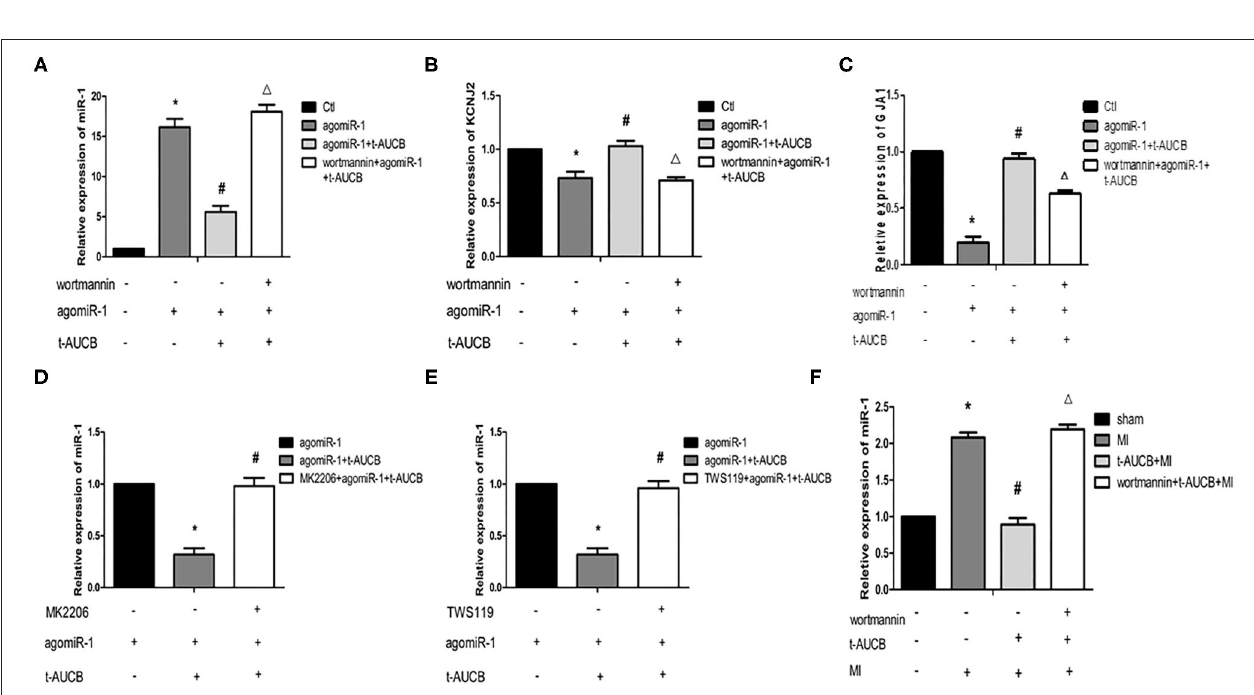
FIGURE 1 | expressions of SRF ( n = 4). (D) Protein bands of SRF silencing mouse model ( n = 4). (E) Relative mRNA expressions of SRF silencing mouse model ( n = 4). (F) SRF participated in t-AUCB-mediated regulation of MI areas in MI mice ( n = 3). (G) Infarct size expressed as percentage of left ventricular area for each group ( n = 3). (H) SRF was involved in the antiarrhythmic effect of t-AUCB ( n = 3). (I) T-AUCB reduced miR-1 in ischemic area, which could be reversed by shSRF ( n = 5). (J) Construction of agomiR-1 model ( n = 4). (K) Construction of SRF silencing cell model ( n = 4). (L) Relative protein expressions of SRF silencing model ( n = 4). (M) SiSRF reversed the negative regulation of miR-1 by t-AUCB in cells ( n = 4). (N) Silencing SRF antagonized the effect of t-AUCB on KCNJ2 ( n = 4). (O) Silencing SRF antagonized the effect of t-AUCB on GJA1 ( n = 4). Compared with the control (Ctl) group, * P < 0.05; compared with the agomiR-1 group, # P and * P < 0.05; compared with the agomiR-1 + t-AUCB group, 1 P and * P < 0.05.